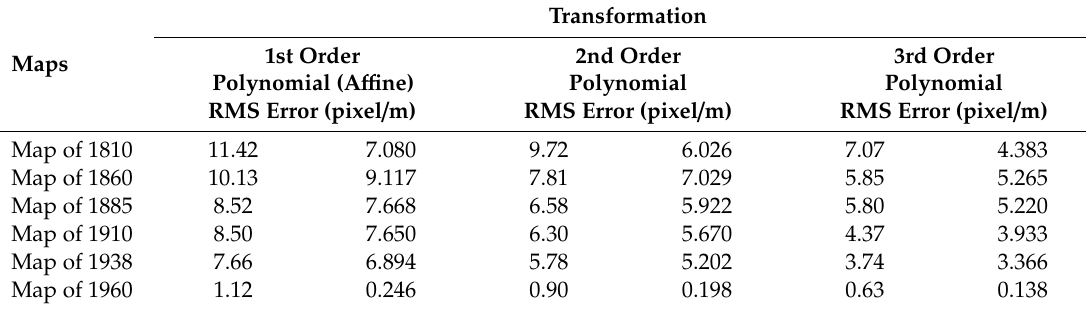
Table 1. Results of the georeferencing of the several